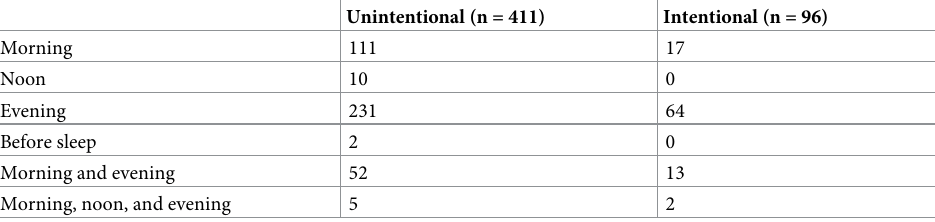
Table 6. Number of missed doses by time of day according to unintentional or intentional reason of the